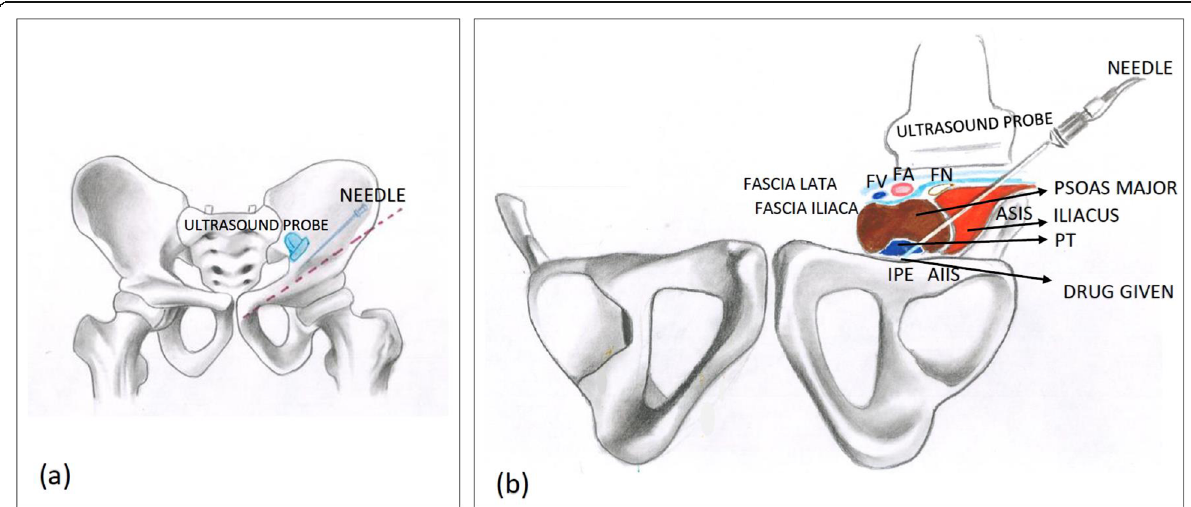
Fig. 4 a Surface marking of the PENG block (standing position): The needle is inserted from lateral to medial in an in-plane approach while the ultrasound probe is positioned to observe the IPE, the iliopsoas muscle and tendon, and the femoral artery. b Pictorial representation of the PENG block (supine position): the needle is inserted from lateral to medial in an in-plane approach while the ultrasound probe is positioned to observe the IPE, the iliopsoas muscle and tendon, and the femoral artery. Abbreviations: ASIS, anterior superior iliac supine, AllS, anterior inferior iliac spine, IPE, ilio-pubic eminence, PT, psoas tendon, FN, femoral nerve, FA, femoral artery, FV, femoral vein